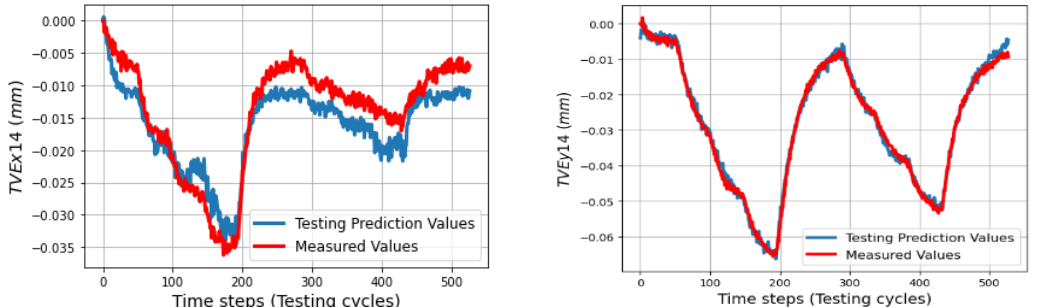
Figure 11. Prediction of TVEx14 and TVEy14 in the long process (LP) (1 cycle = 15 min) .